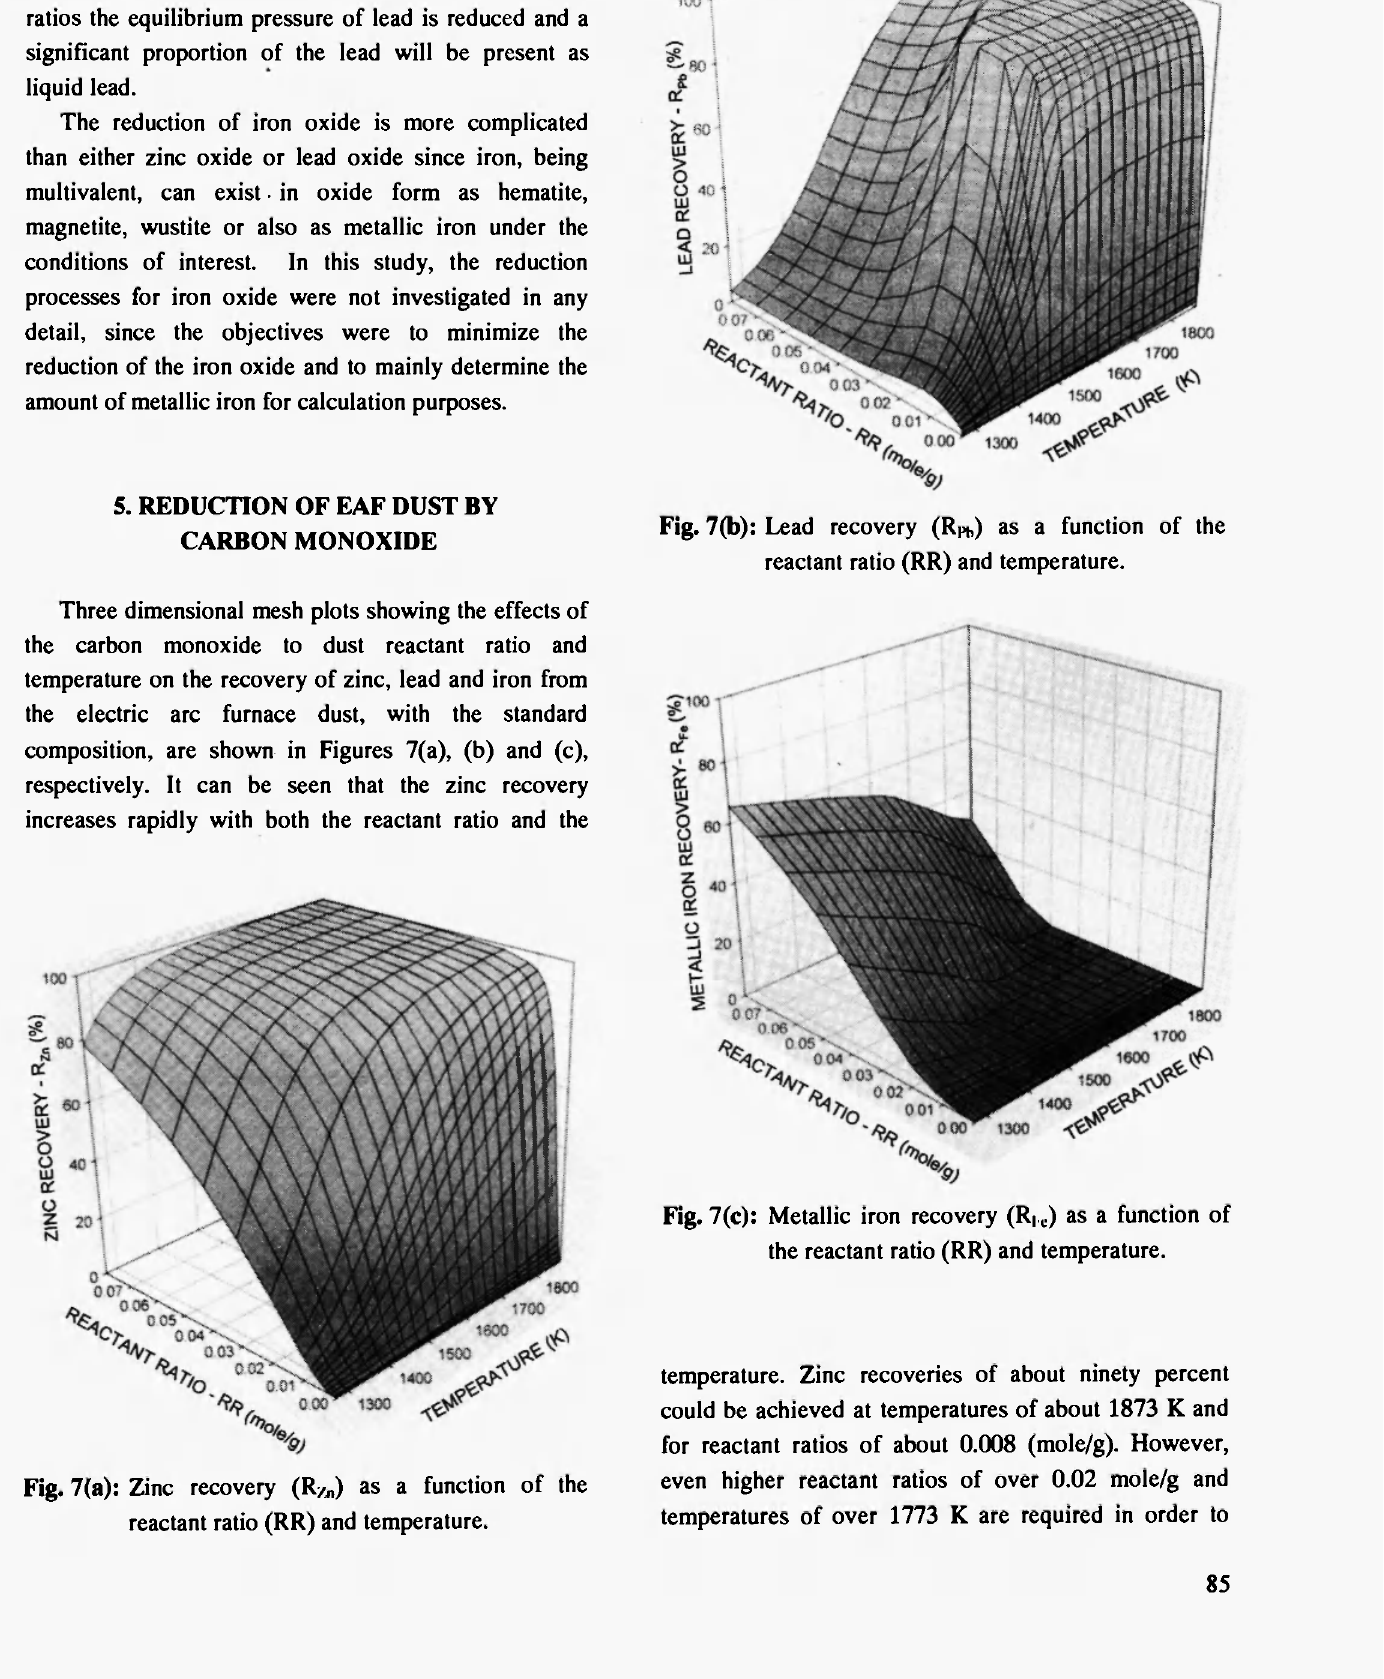
Fig. 7(c): Metallic iron recovery (R|. c ) as a function of the reactant ratio (RR) and